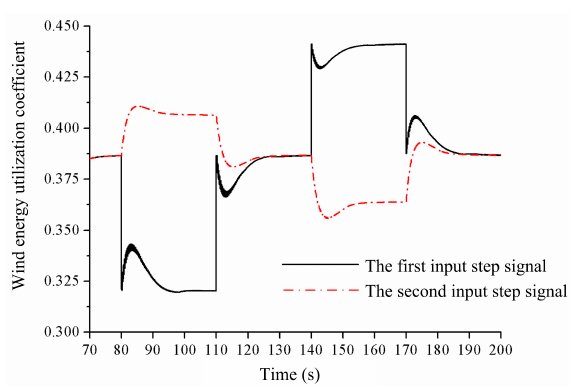
Figure 15. The wind energy utilization coefficient curve.